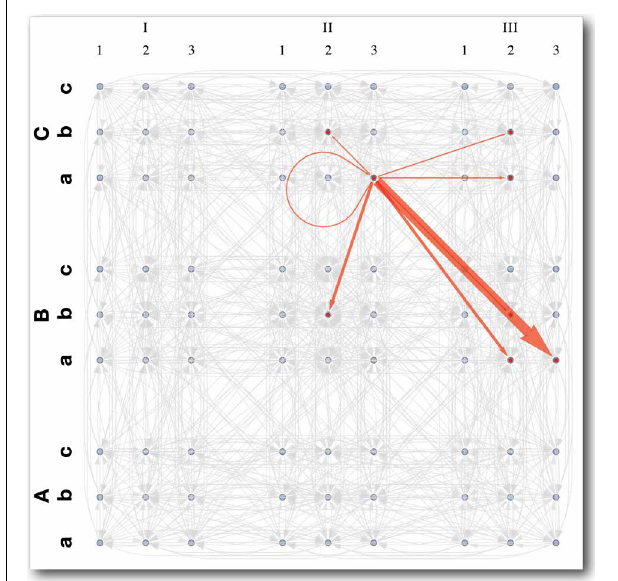
FIGURE 9 | State space and transition distribution for an interesting arm action in multi-agent system. The 4D state space is labeled as follows: shoulder flexion/extension (1,2,3), arm abduction/adduction (a,b,c), lateral/medial arm rotation (I,II,III), elbow flexion/extension (A,B,C). The red arrows show the distribution of next states resultant of an interesting state-action, which causes the hand to interact with the table. Each arrow represents a state transition probability and the weight of the arrow is proportional to the magnitude of that probability. Arrows in gray represent boring state-actions. These work as expected, reliably taking the agent to the intended goal state, to which they